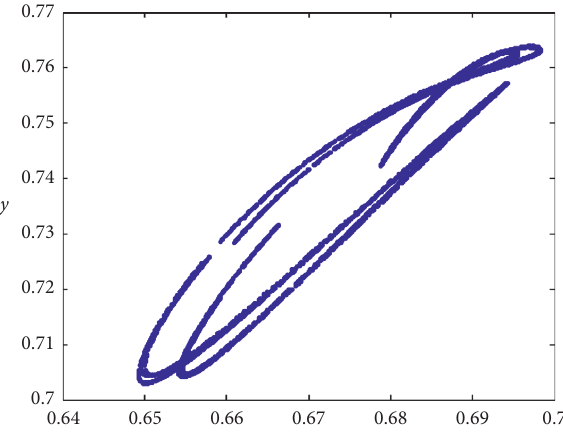
Figure 9: x - y phase diagram which denotes that the system is chaotic when α �